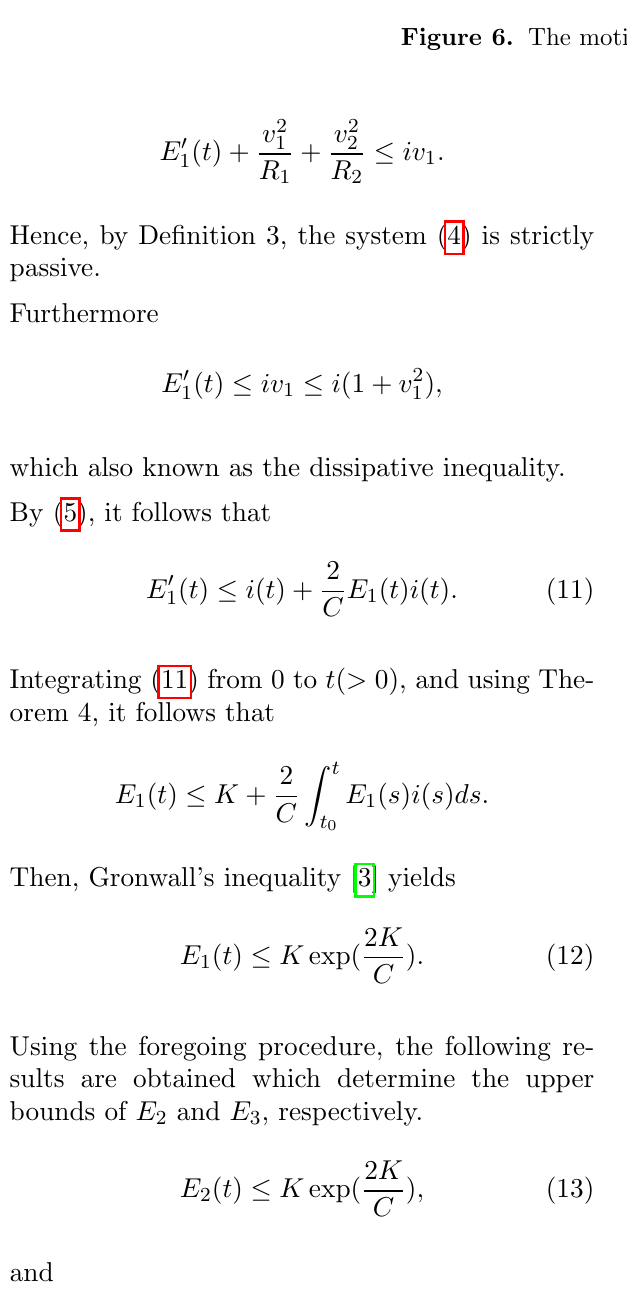
Figure 6. The motions of system